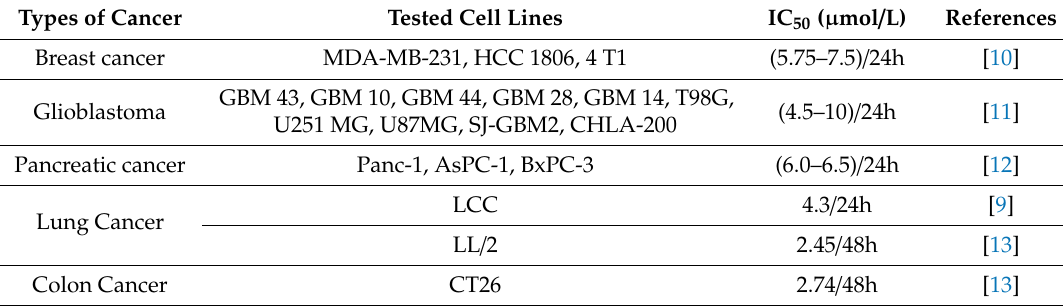
Table 1. Types of cancer were inhibited by penfluridol.